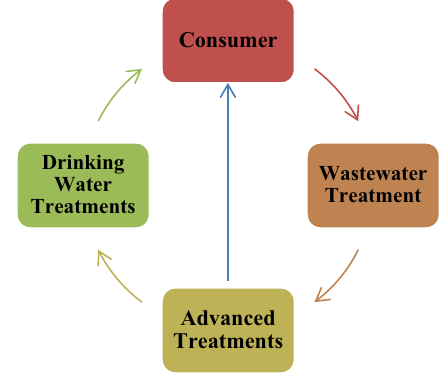
Fig. 3 Direct potable reuse (DPR) cycle for reusing